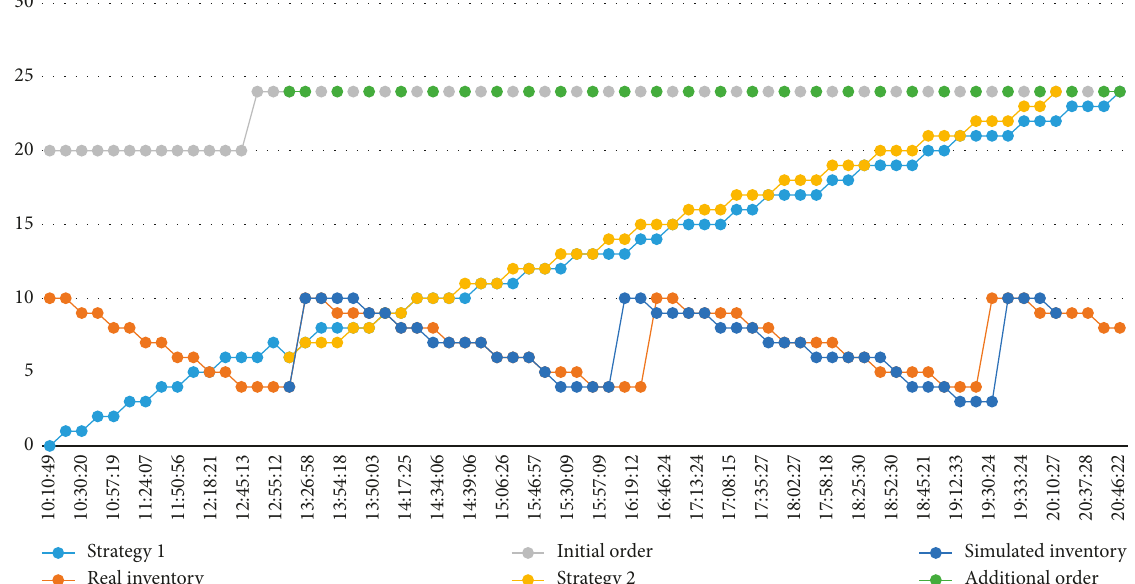
Figure 9: Digital Twin Model of CPPS prototype.